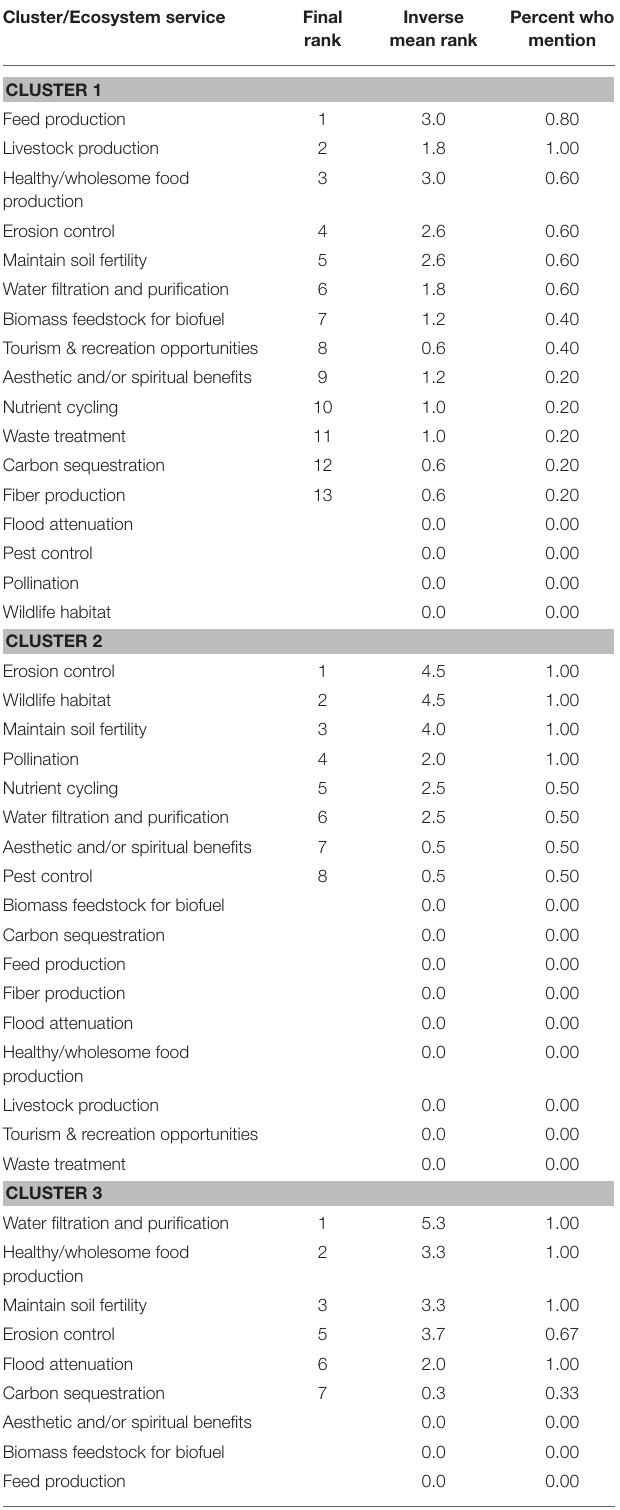
TABLE 4 | Ecosystem service items sorted into four clusters as identified in agglomerative cluster analysis. Final rank was calculated by multiplying percent-who-mention by the inverse of the mean rank among